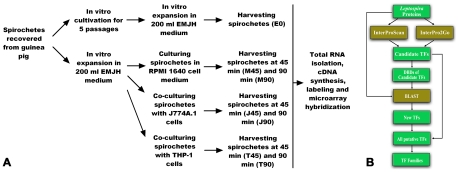
Schematic representation of the macrophage infection models (A) and search tactics of specific transcription factors from the leptospiral genomes (B).